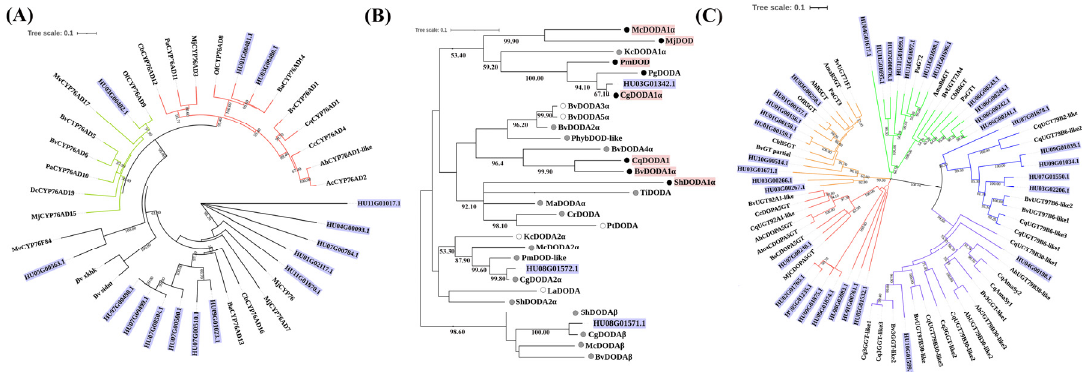
Figure 2. Neighbor-Joining phylogeny of CYP76AD ( A ), DODA ( B ) and GTs ( C ) with the other plant species. ( A ) The red lines indicate α evolution branch, green lines indicate β evolution branch and the other belong to γ branch; ( B ) Red background labeled tips show functionally characterized DODAs. Purple rhombus indicates candidate genes from H. undatus . Labeled tips shaded squares correspond to DODA activity (white, no activity; grey, marginal activity; black, high activity); ( C ) Branches are colored according to the putative characterized GTs (red, CDOPA5GT; orange, B5GT; green, B6GT; blue, UGT79B6; purple, UGT79B30). Purple label backgrounds indicate candidate genes from H. undatus